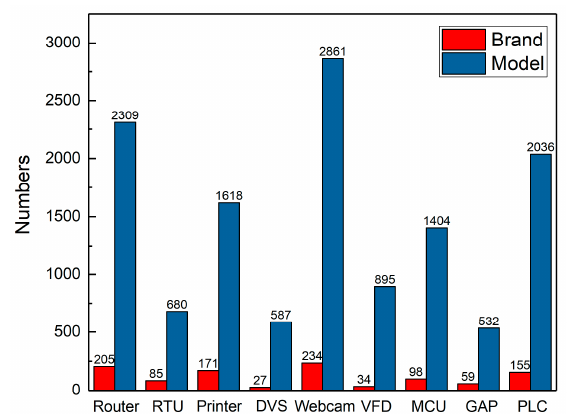
Figure 4. Device brand and model statistics.